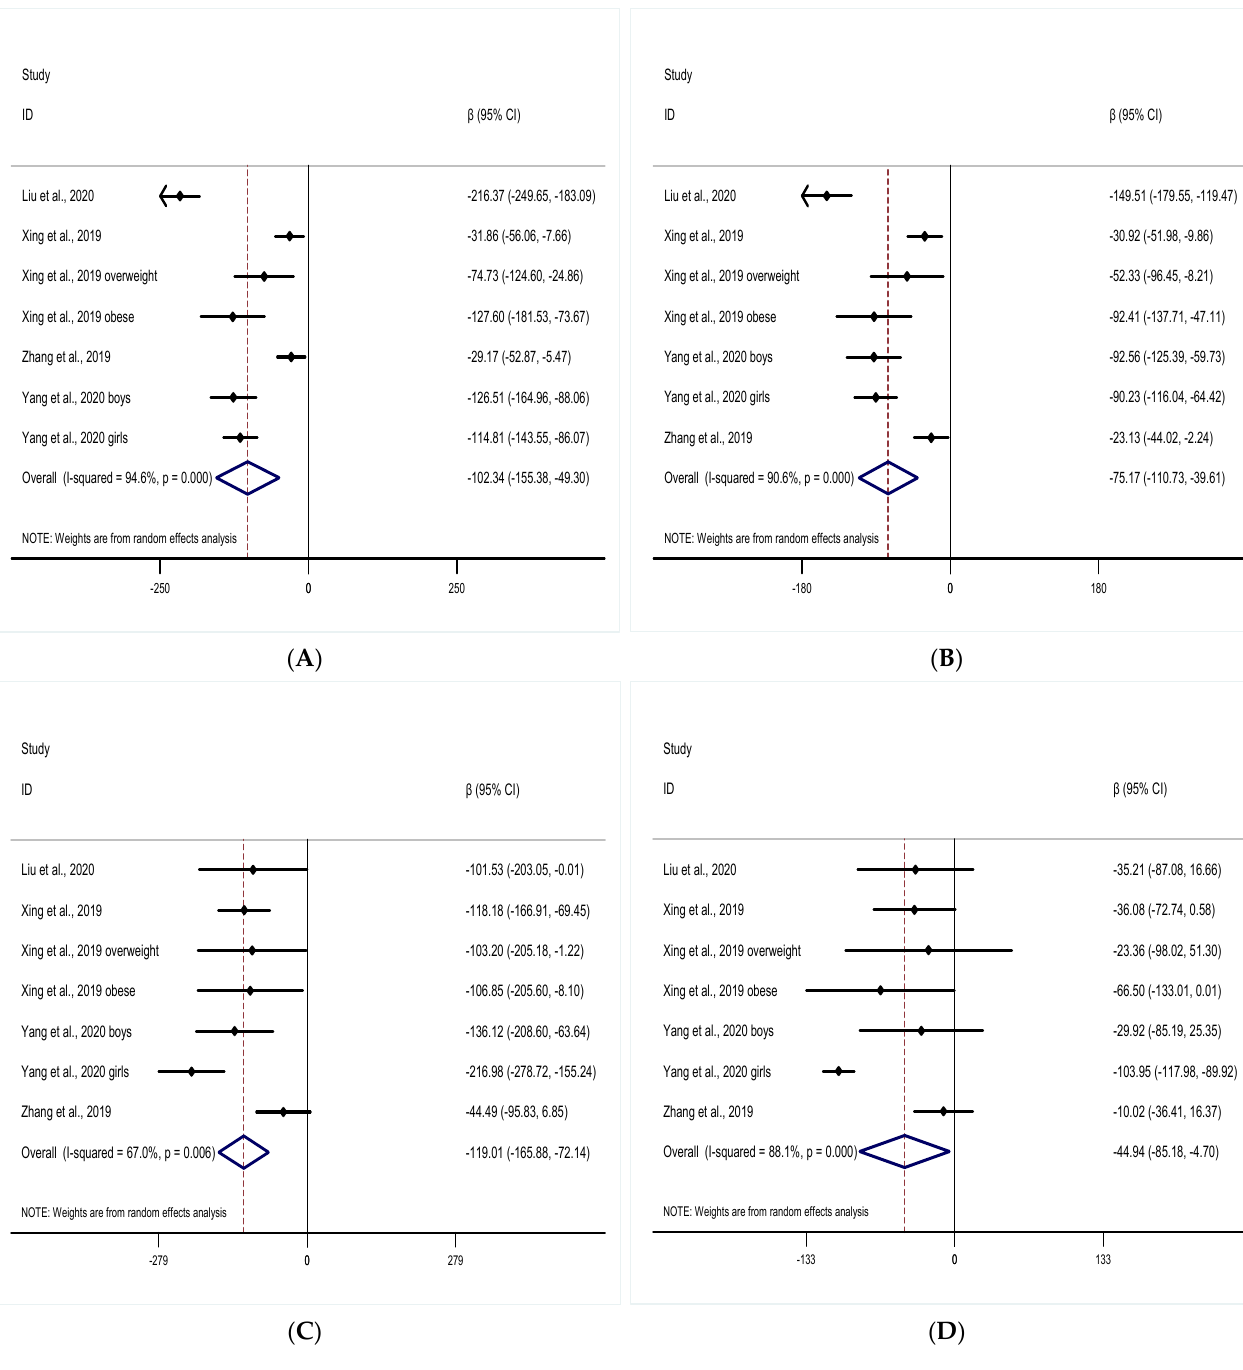
Figure 3. Forest plot of the meta-analysis: per 10 μ g/m 3 increase of PM 1 was associated with pooled β values of lung function indicators in the long-term group: ( A ) FVC, ( B ) FEV 1 , ( C ) PEF, ( D ) MMEF [30,33–35]. The open diamonds represent the combined β value for each group. The solid line represents β value = 0.